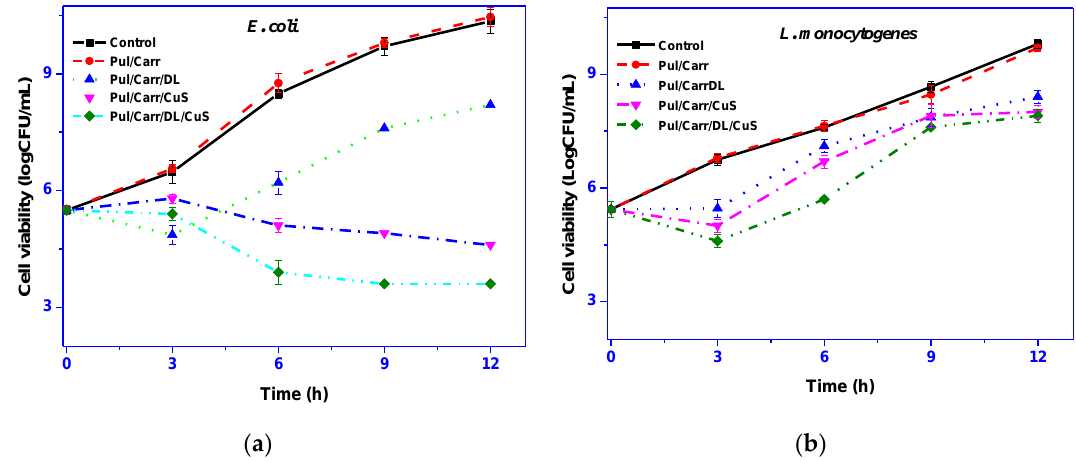
Figure6. Antimicrobialactivityofpullulan / carrageenan-basedfilmsagainst( a ) E.coli and( b ) L.monocytogenes Figure 6. Antimicrobial activity of pullulan/carrageenan-based films against ( a ) E. coli and ( b ) L. monocytogenes .